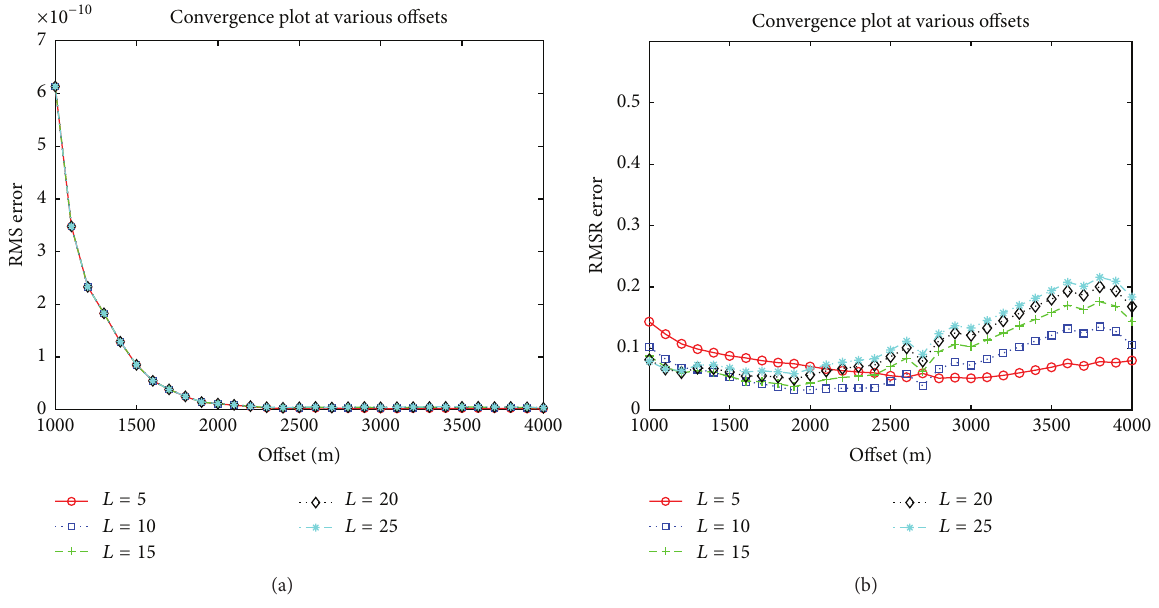
used over the two sides is given as 76 × 56. The RMS